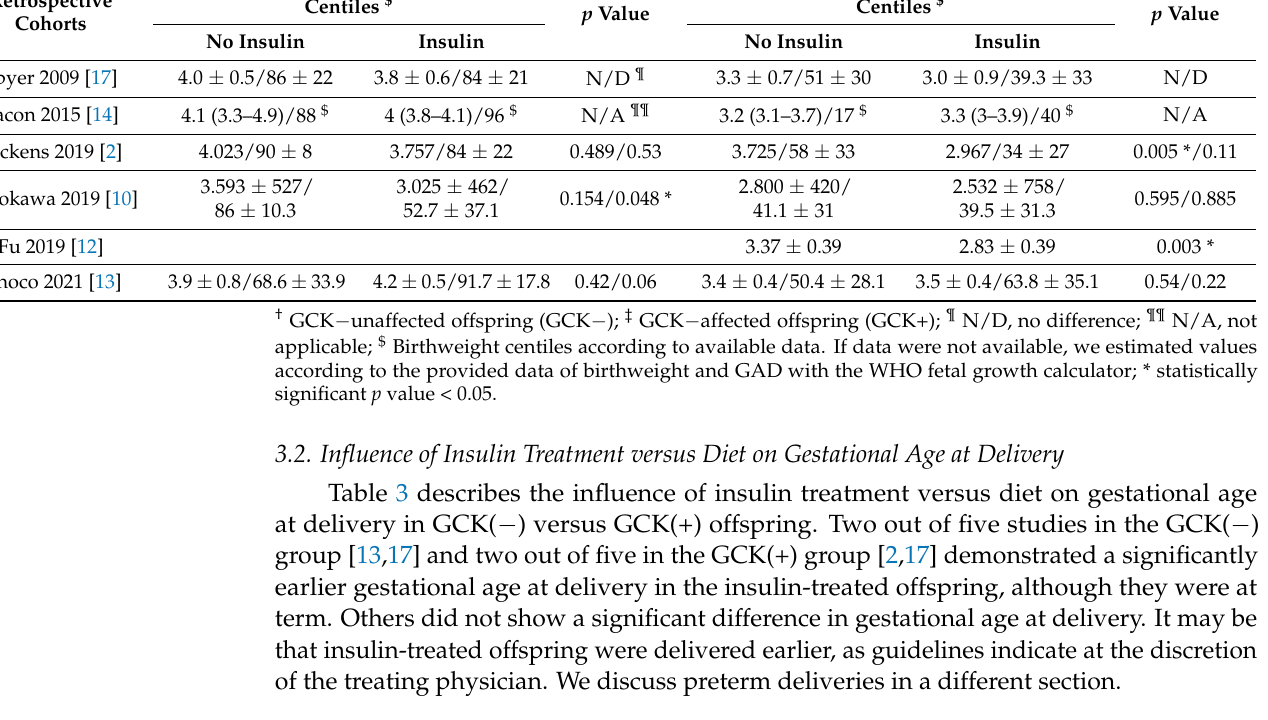
Table 3. Gestational Age at Delivery in Treated Versus Untreated